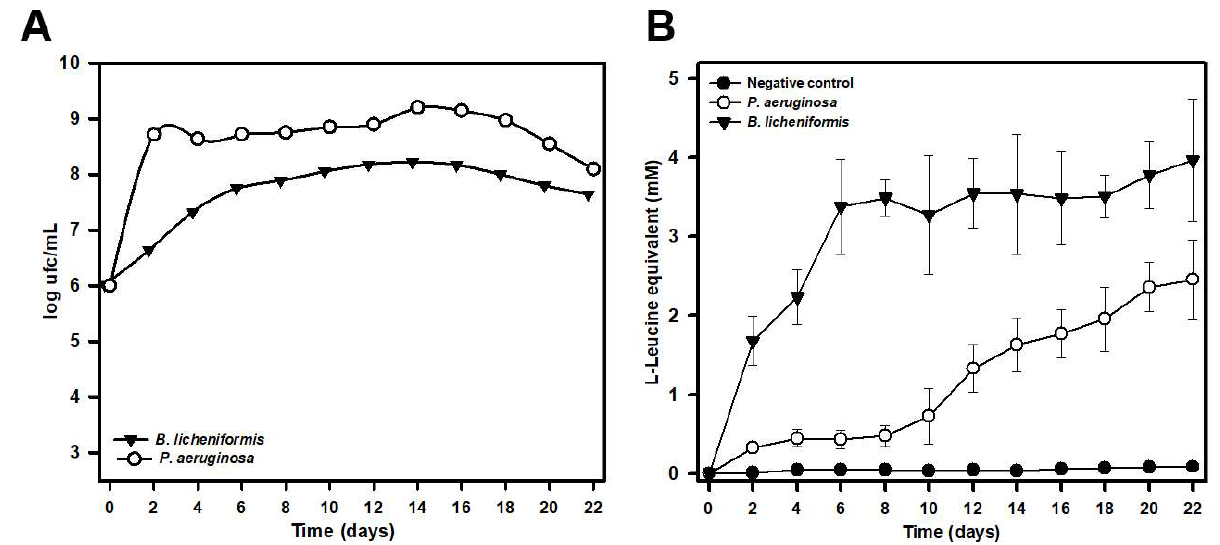
Figure 4. Growth rate of P. aeruginosa IIVV-SD1 and B. licheniformis IIVV-SD3 strains in a minimal medium supplemented with raw silk ( A ), and biodegradation of pine processionary raw silk esti- mated by release of L-Leucine equivalent (mM) into the culture medium ( B ). Bacterial cultures were run in parallel to a negative control of raw silk incubated in a non-inoculated minimal medium. The results shown are the average of two different experiments performed in triplicate.